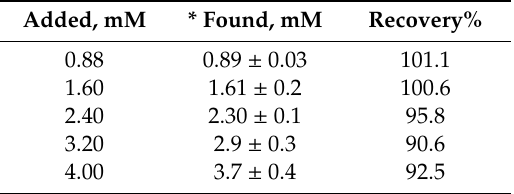
Table 4. Determintion of Orcinol content in soil samples using GC / Gr / MIP / AA-ISE. Added, mM * Found,